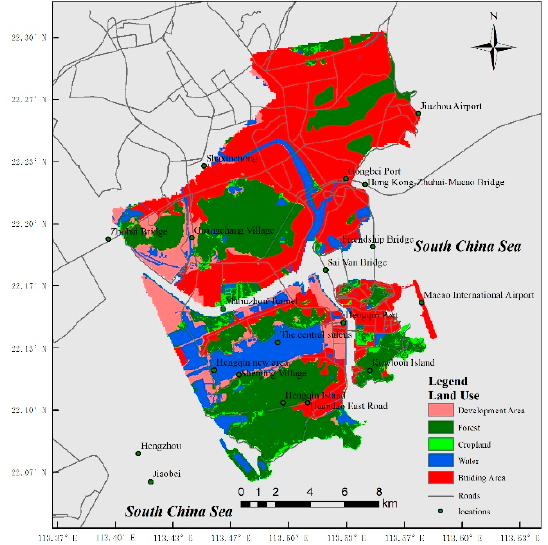
Figure 3. Distribution map of land use in the study area.